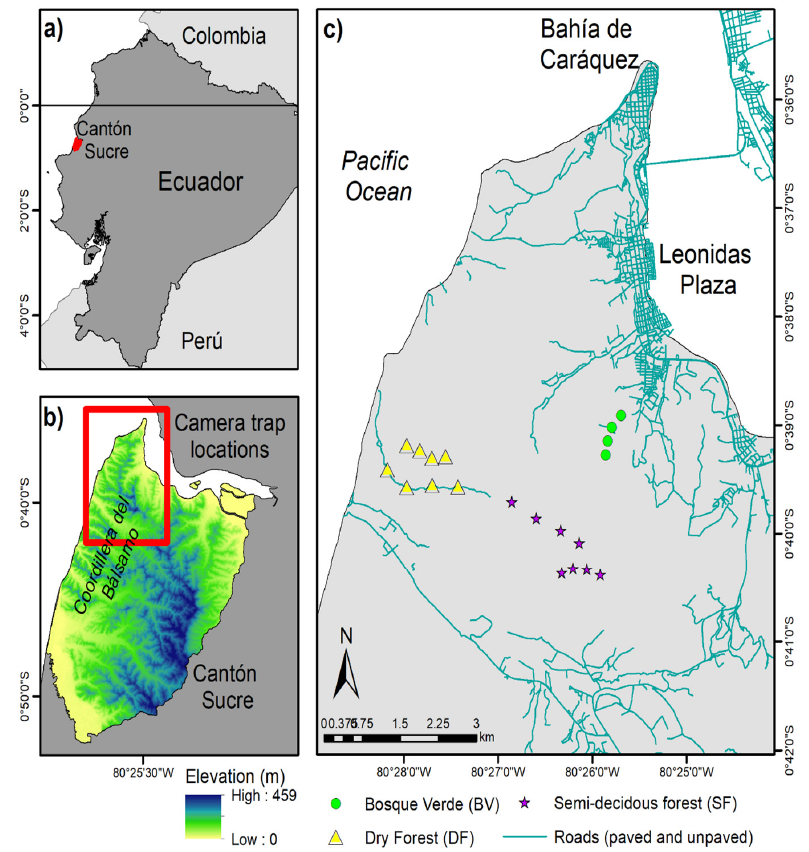
Figure 1. Study landscape. ( a ) Location of Cantón Sucre within Ecuador; ( b ) Section of the study landscape where camera traps were used; ( c ) The three camera trap sampling areas.